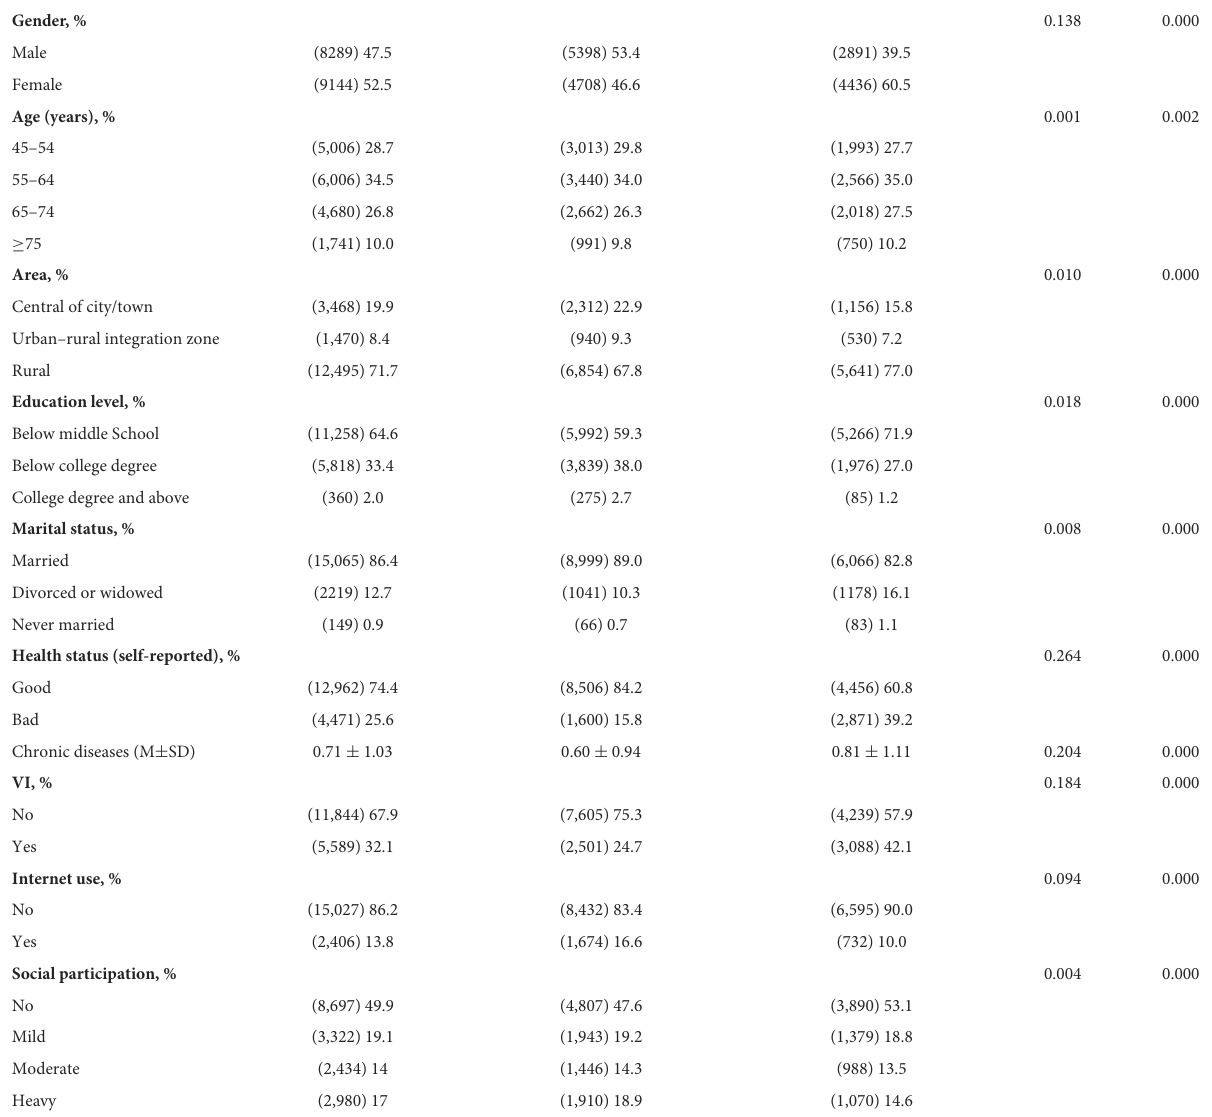
TABLE 1 Basic characteristics of the